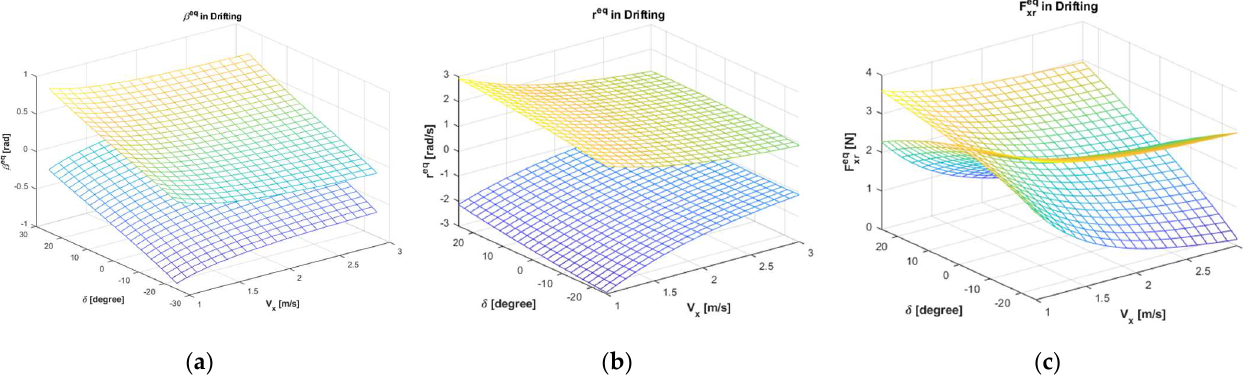
Figure 8. Vehicle state during drift driving. 4. Drift-Driving Test of the Nonlinear Model Predictive Controller 4.1. Test Scenario The performance of the NMPC-based drift control method was evaluated through numerical simulations. The controller was required to follow 8-shaped trajectories with diameters of 2 m ( ① and ② ) and 2.5 m ( ③ and ④ ), as shown in Figure 9. The control period and NMPC prediction period were set to 50 Hz (0.02 s) and 20 steps, respectively. Under these settings, the NMPC system can predict the maneuver for 0.4 s.